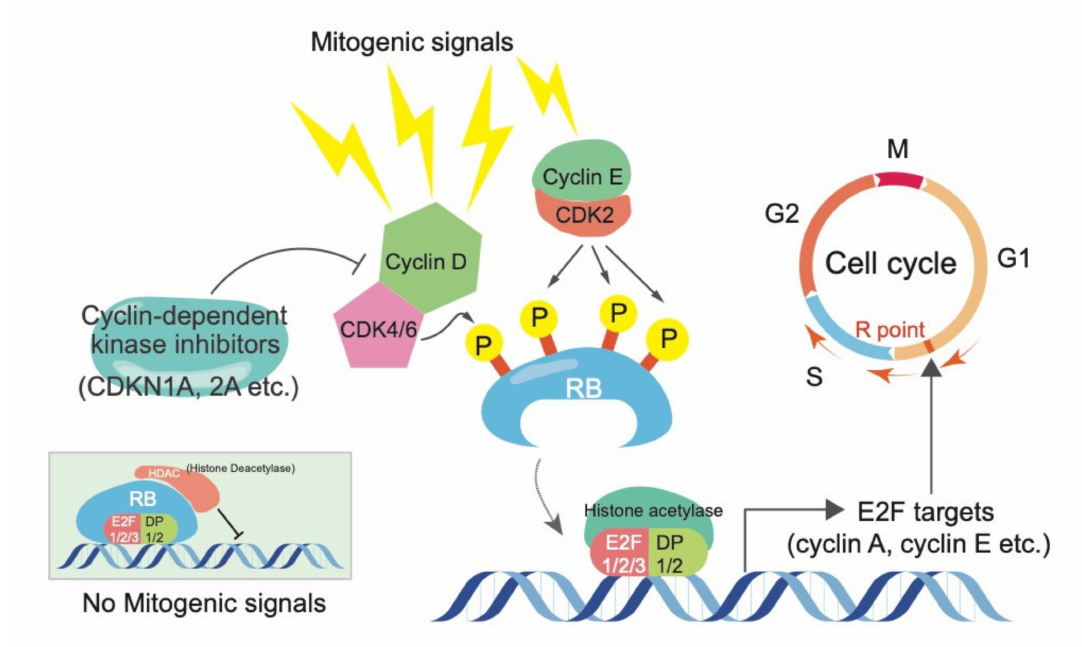
Figure 1. The canonical RB function in controlling cell cycle progression. Cyclin-CDK complexes regulate RB activity via phosphorylation, while cyclin-dependent kinase inhibitors suppress the activity of Cyclin-CDK complexes. Phosphorylated RB releases E2Fs, which stimulate cells to enter to the S and M phases via induction of E2F targets, such as cyclin A and